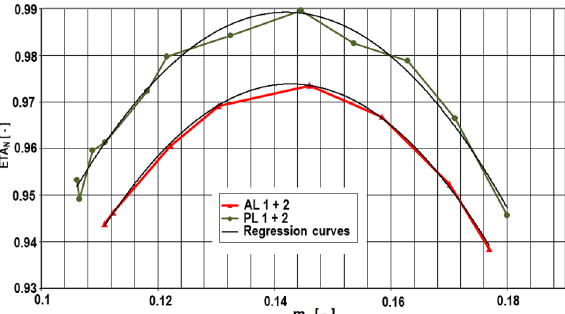
Fig. 11. Efficiency characteristics in the practical operating range of the stage at Ma 2u = 0.9 . Polynomial regression curves added.